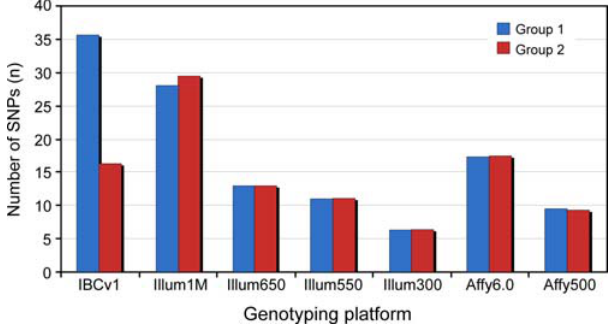
Figure 3. Average number of SNPs per Group 1 and 2 loci, respectively, on IBCv1 compared with the major GWAS products. IBCv1 Group 1 and Group 2 loci (n=435 and 1,349) are captured at MAF . 0.02, r 2 0.8 and MAF . 0.05, r 2 0.5 in HapMap populations and SeattleSNPs, and illustrated in blue and red respectively. IBCv1 refers to the ITMAT-Broad- CARE version1 array, Illum650, Illum550 & Illum300 refer to Illumina HumanHap650Y, HumanHap550 and HumanHap300 Infinium products containing , 660 K, , 550 K & , 317 K SNPs respectively and Affy 6.0 and Affy 5.0 refers to Affymetrix SNP array products containing , 907 K & 500 K respectively.